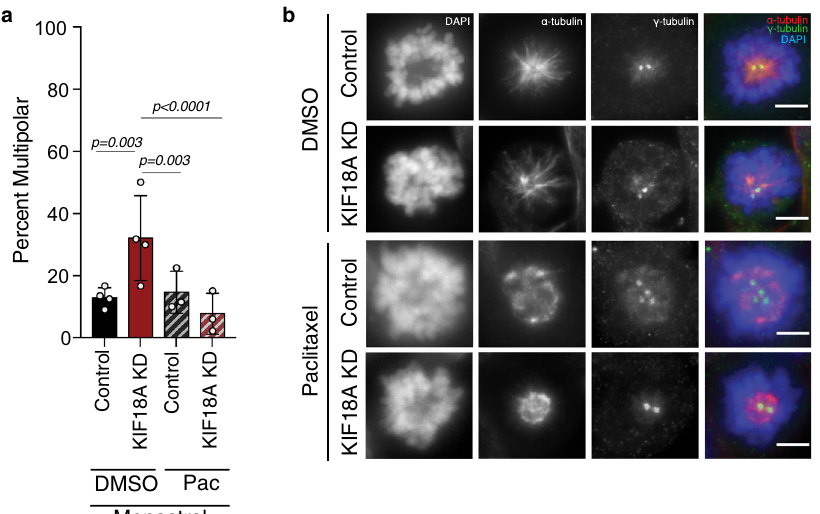
Fig. 7 Centrosome fragmentation in KIF18A KD cells does not require bipolar spindle formation. a Percent of monopolar MDA-MB-231 cells with three or more γ -tubulin puncta in control or KIF18A KD cells treated with both monastrol (20 μ M) and either DMSO or 20nM Paclitaxel (Pac). n (number of monopolar mitotic cells/number of independent experiments) = 112/4 (control KD + DMSO), 102/4 (KIF18A KD + DMSO), 132/3 (control KD + Pac), and 149/3 (KIF18A KD + Pac). The plot shows mean± SD with individual data points indicated. Data were analyzed via a two-sided Chi-square test, and P values <0.05 are displayed. b Representative images (from three independent experiments) of MDA-MB-231 cells treated with 20 μ M monastrol and either DMSO or 20nM Paclitaxel. DNA (DAPI, blue), microtubules ( α -tubulin, red), and centrosomes ( γ -tubulin, green) are labeled. Scale bar is 5